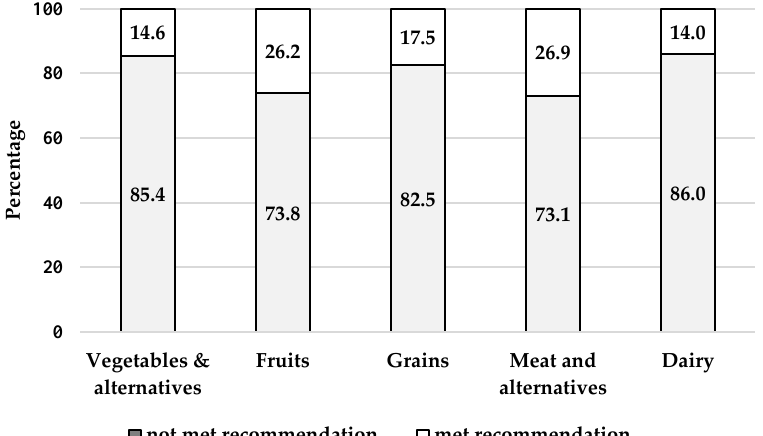
Figure 1. Adherence to food group recommendations in all reproductive age women ( n = 2323). Aus- tralian Guide to Healthy Eating recommendations for vegetables & alternatives ( ≥ 5 servings), fruits ( ≥ 2 servings), grains ( ≥ 6 servings), meat and alternatives ( ≥ 2.5 servings), and dairy ( ≥ 2.5